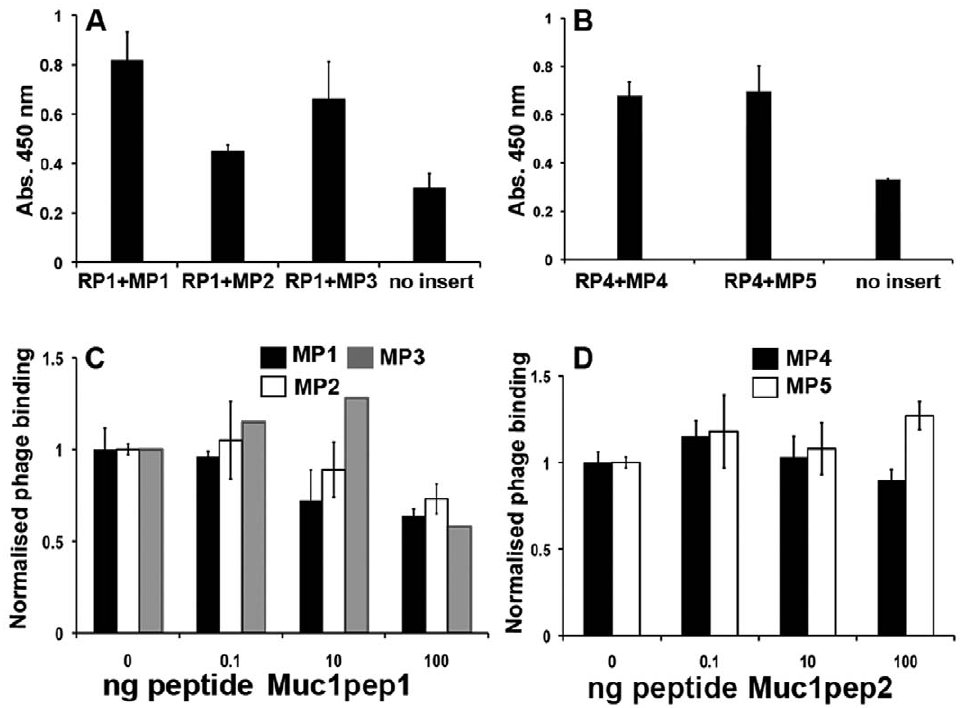
Figure 2. Interaction of Recogniser and Mimic peptides. A. Phages bearing the mimic peptides MP1-3 or no insert were incubated with biotinylated RP1 peptide, immobilized on Streptavidin coated microtitre plates. Bound phages were quantified by measuring OD 450 nm following incubation with HRP conjugated anti-M13 monoclonal antibody and the chromogenic substrate TMB. Error bars represent the standard deviation between two independent samples. B. as for A except that the bound peptide RP4 was incubated with the phages bearing the peptides MP4-5 or no insert. C. As in A except that the phage particles were pre-incubated with increasing concentrations (ng) of the MUC1pep1 core peptide prior to incubation with RP1. Phage binding in the presence of competitor was normalised to the binding in the absence of competitor, which was set at an arbitrary value of 1.0. Error bars represent the normalized % error from two independent samples. MP1; black, MP2, white, MP3, grey. D. as in B except that the immobilized peptide was RP4 which was incubated with the mimic peptides MP4 (black) or MP5 (white). The competing peptide was the MUC1pep2 core peptide.